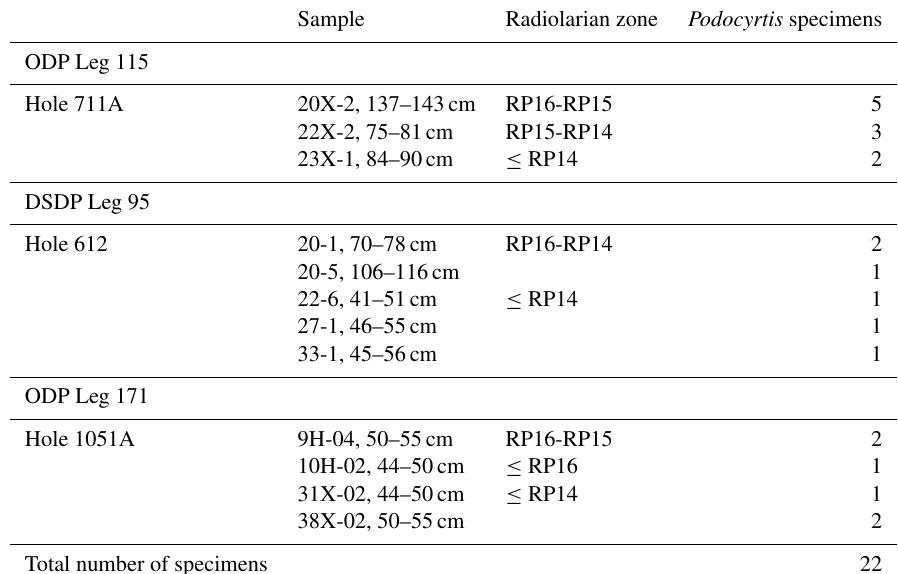
Table 2. Number of specimens per species for each sample coming from ODP Leg 115, DSDP Leg 95 and ODP Leg 171, which were used for the